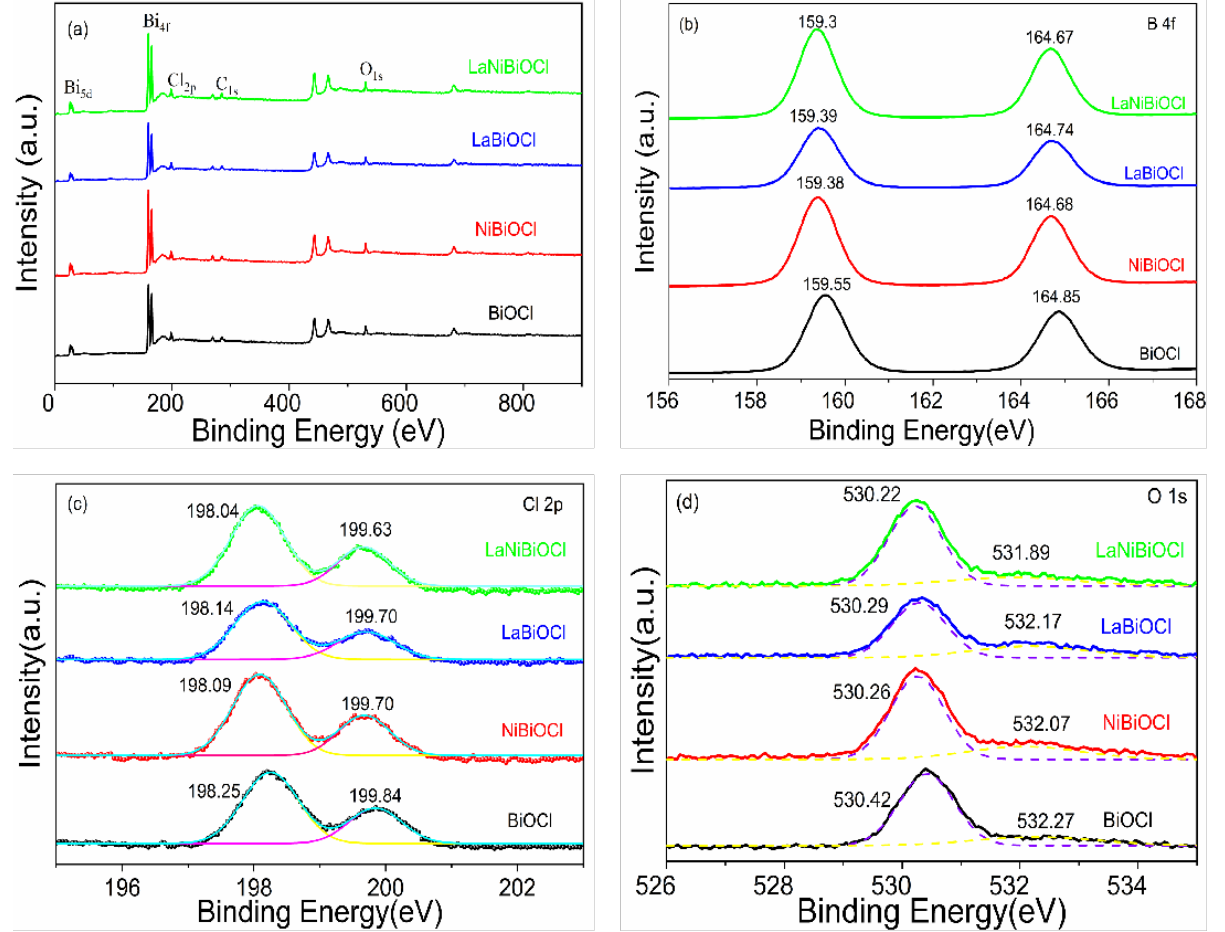
Figure 3. XPS survey and corresponding high-resolution spectra of as-prepared samples. ( a ) Survey spectra ( b ) Bi 4f, ( c ) Cl 2p, and ( d ) O 1s.